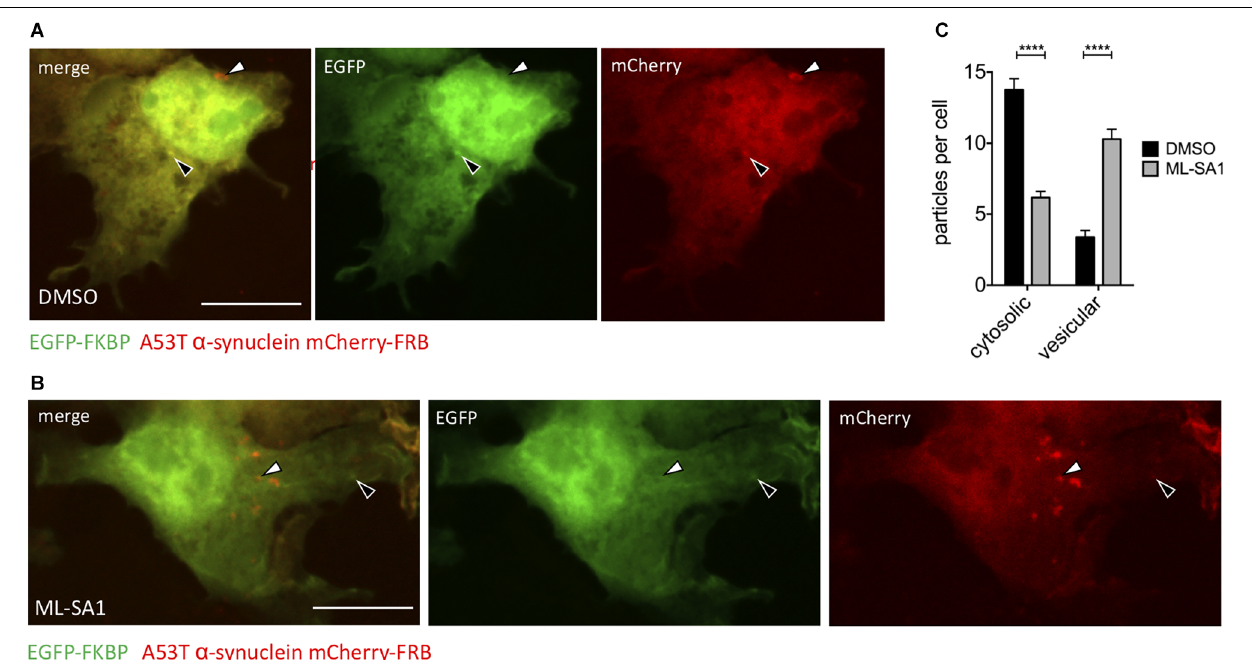
FIGURE 3 | TRPML1-Agonist ML-SA1 increases number of vesicle-bound α -synuclein. (A,B) Example images of HEK293T cells transfected with A53T- α -synuclein fused to mCherry-FRB and coexpressed with EGFP-FKBP. Treatment of cells with DMSO (A) or 25 µ M ML-SA1 for 18 h (B) . Addition of rapamycin leads to heterodimerization of FRB and FKBP, recruiting GFP-FKBP to cytosolic synuclein-mCherry-FRB but not to synuclein contained in vesicles. The white arrows mark “mCherry only” particles which represent vesicles, black arrows mark cytosolic α -synuclein particles (yellow in merged images). Scale bars represent 20 µ m. (C) The number of cytosolic particles and vesicles from n = 3 independent experiments. Two-way ANOVA (factors treatment and particle type) showed significant interaction ( p < 0.0001). Sidak’s multiple comparisons test is depicted with respect to DMSO. **** p < 0.0001, non-significant differences are depicted as